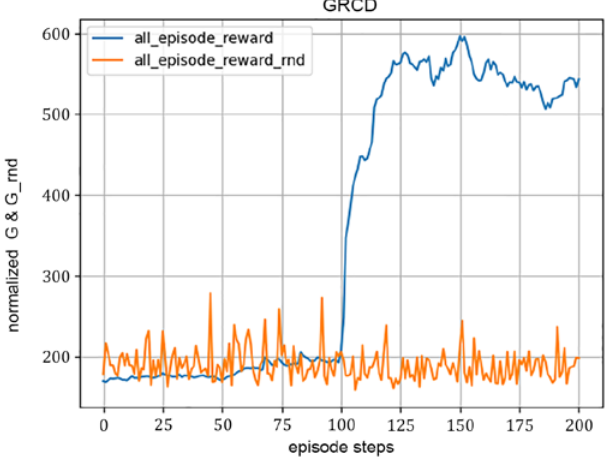
Figure 4. Convergence performance of the proposed algorithms with N = 49, Hidden_dim = 256.